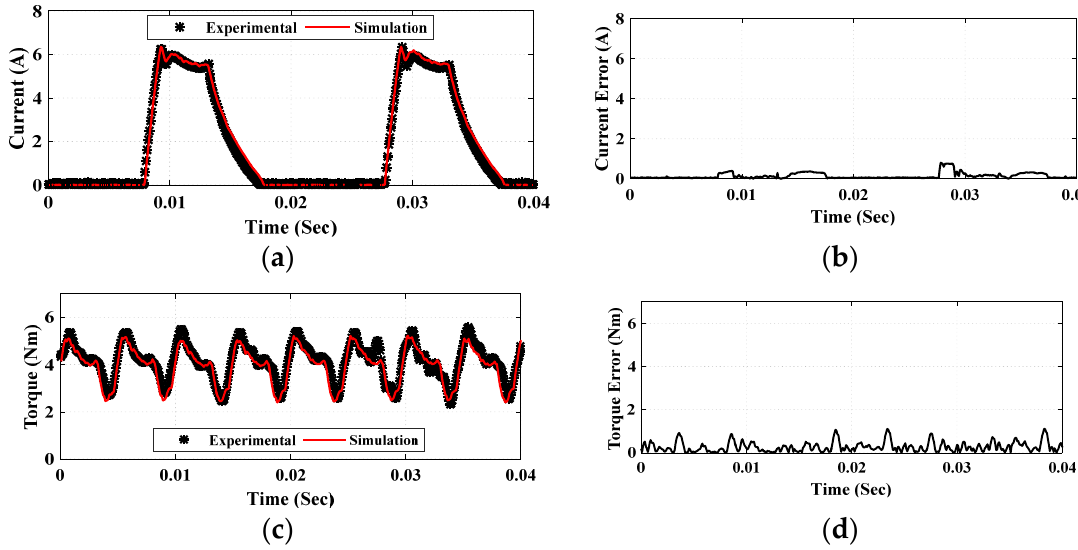
Figure 14. Comparison between the experimental and simulation results at 505 r/min: ( a ) phase current; ( b ) current error; ( c ) torque; ( d ) torque error. Table 2. Comparison between the simulation and the experimental results. Parameter